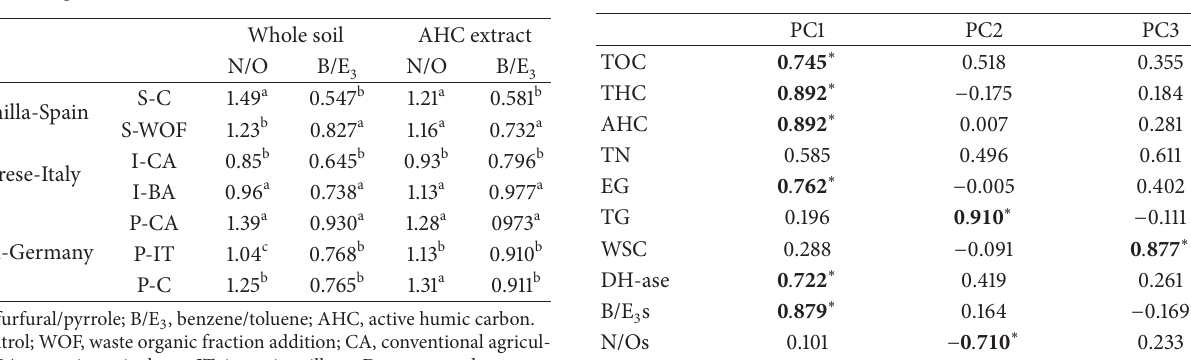
Table3:Pyrolyticindicesofmineralization(N/O)andhumification ). For each site, different letters indicate statistically different (B/E 3 values among the treatments ( 𝑃 < 0.05 ).